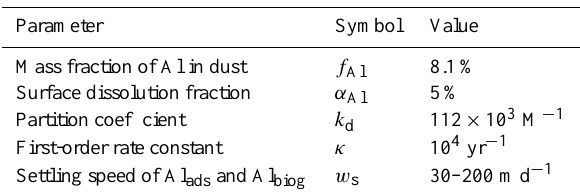
Table 2. Parameters for the reference simulation RefDyn2 (identical to those of